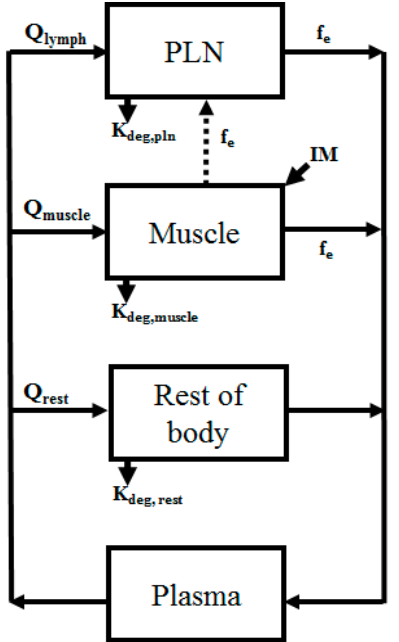
Figure 2. Schematic represent of the semi-mechanistic PBPK model. Arrows indicate flow between organs. Dashed lines indicates lymphatic draining. IM: intramuscular administration.